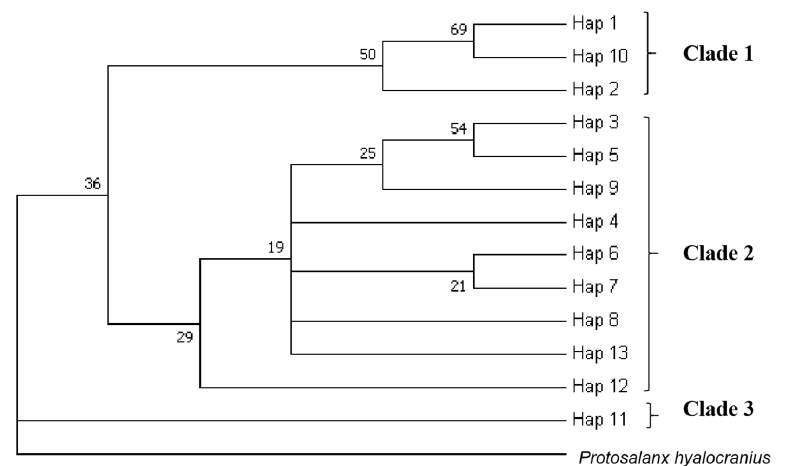
Figure 4. NJ tree of N. taihuensis in different populations by the Kimura 2-parameter model. Note: Numbers at nodes represent bootstrap values. Numbers at nodes represent bootstrap